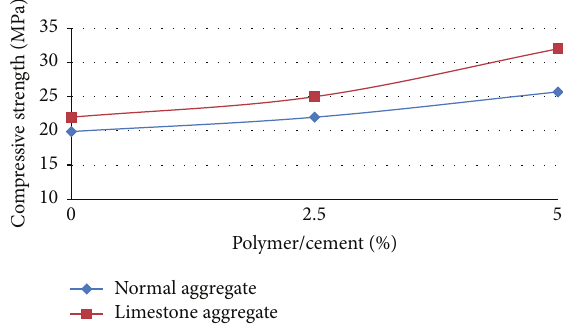
Figure 12: The effect of the aggregates type on the compressive strength at different polymer content and 0% MK at age of 28 days.